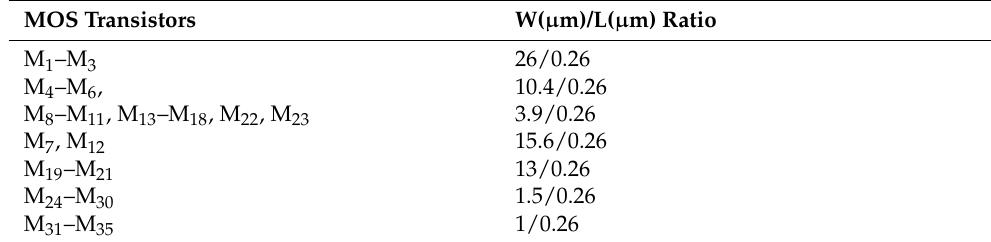
Table 1. W/L ratios of MOS transistors.